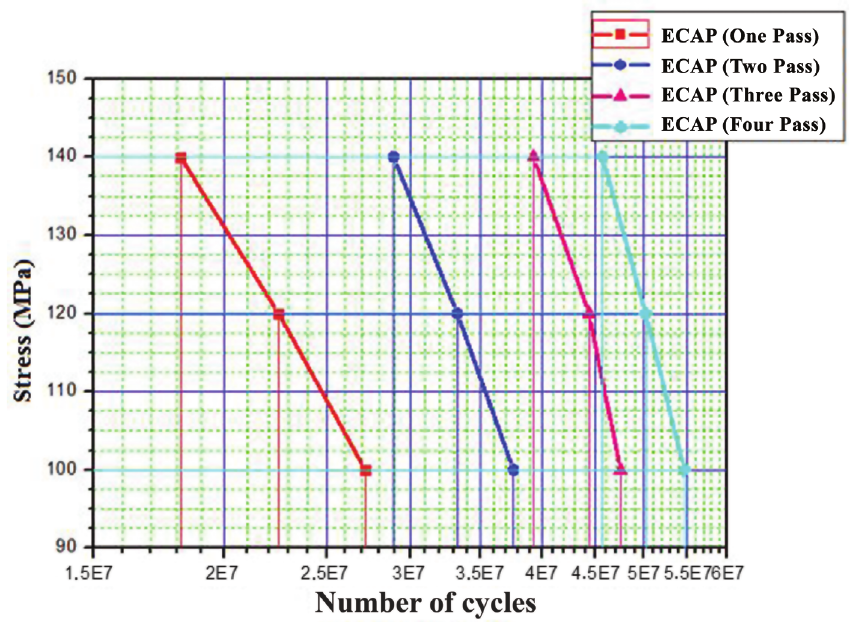
Figure 7: Comparative S – N curve of ECAP one pass, two pass, three pass, four pass of AA7075